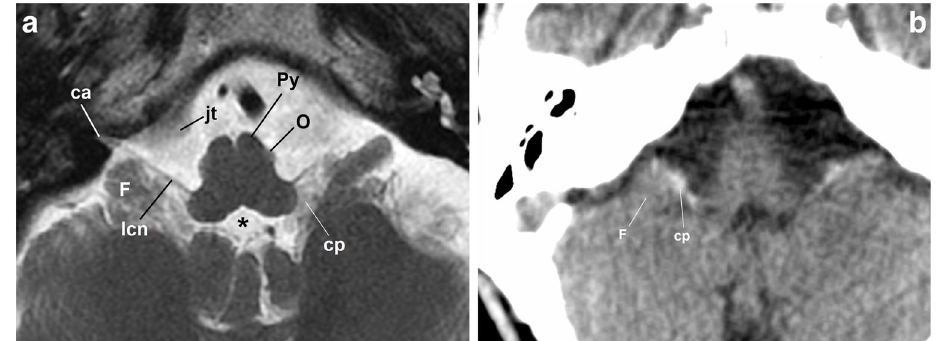
Fig. 3 a Axial fast spin-echo T2-weighted brain MRI at the level of the medulla oblongata. The image shows the lower cranial nerves (lcn) passing by the flocculus (F), the choroid plexus (cp) outside the fourth ventricle (*) and the jugular tubercle (jt) as they approach the cochlear